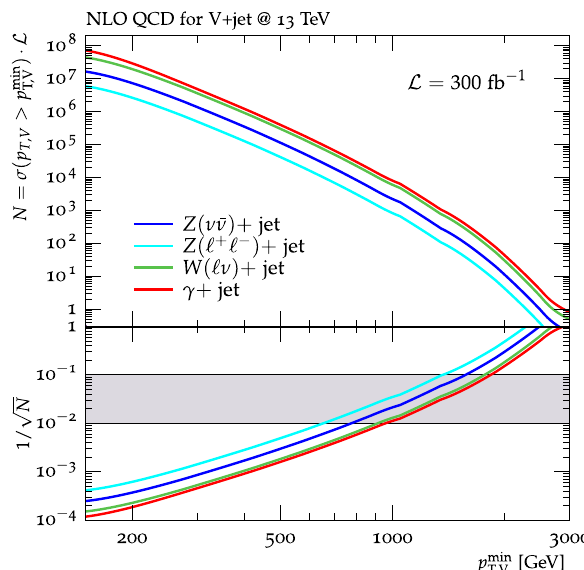
Fig. 1 Production rates for V + jet(s), for various decay channels, as a function of the minimum p T of the vector boson. Decays into (cid:3) ± = e ± ,μ ± and ν ,ν ν ,ν τ are included. The number of events, N , √ e s = 13TeV, and includes is normalized to 300fb − 1 of LHC data at the basic selection cuts listed in the main body of the paper. The log √ N .The lowerpanelshowsthestatisticaluncertainties,calculatedas1 / gray band in the lower panel indicates the regime of 1–10% statistical